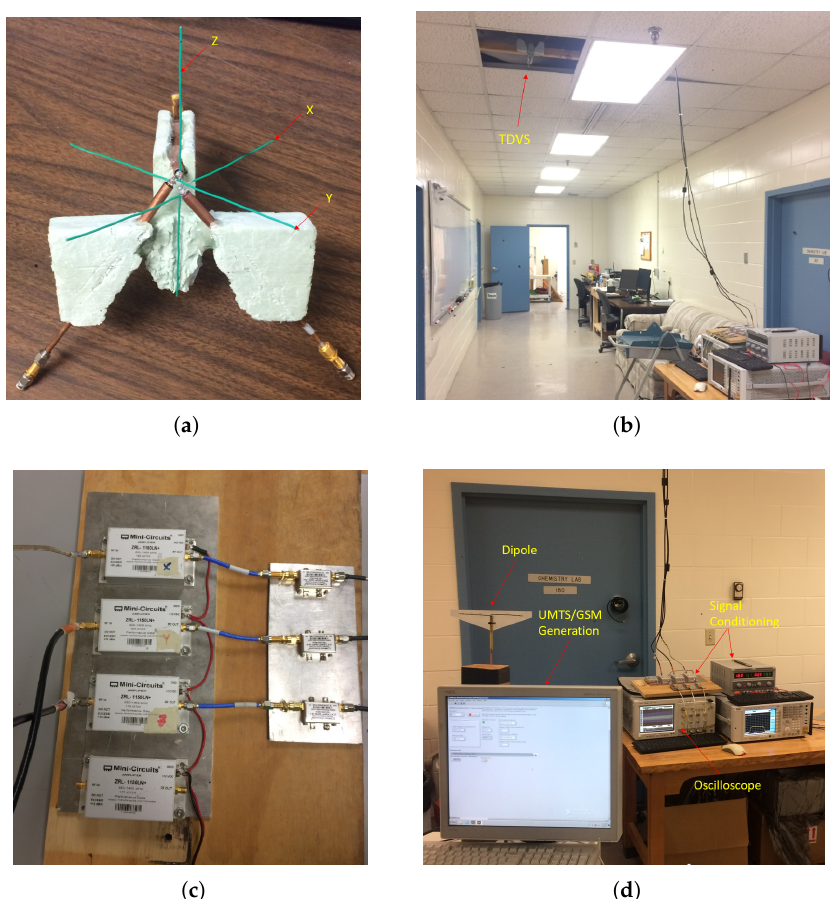
Figure 4. Experimental configuration. ( a ) TDVS, ( b ) Mount/Receiver Setup, ( c ) LNA-BPF, ( d ) Transmit/Receive.